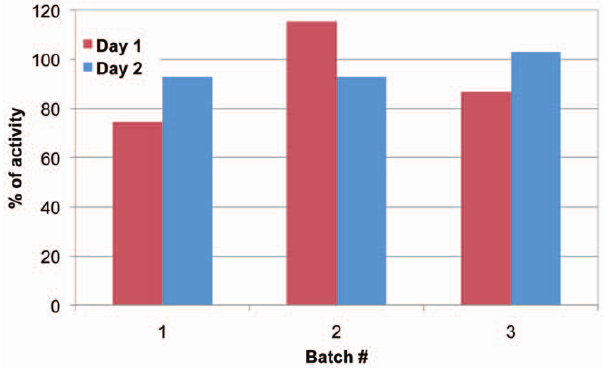
Figure 5. Recycling of the biocatalyst. A 500 m l aliquot of magnetosomes suspension is immobilized onto the magnetic column. A 1 ml sample contaminated with 50 m M ethyl-paraoxon is passed through the column by flow gravity and recovered for p -nitrophenol spectrophotometric assay. The column is stored at room temperature with the magnetosomes and the experiment is repeated two more times at 2-hour intervals. Magnetosomes still magnetically retained on the column are stored at 4 u C overnight and the entire set of experiments is repeated the next day. The hydrolysis activities are plotted for each repeat (100% activity expresses the complete degradation of ethyl-paraoxon by the purified enzyme) for day 1 (red) and day 2